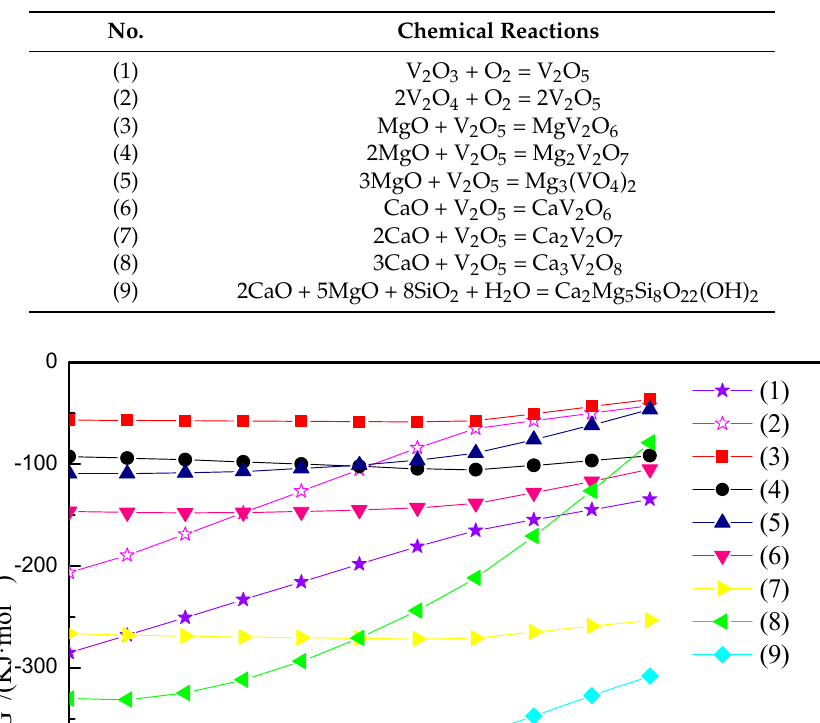
Table 4. The main chemical reactions during stone coal roasting process.